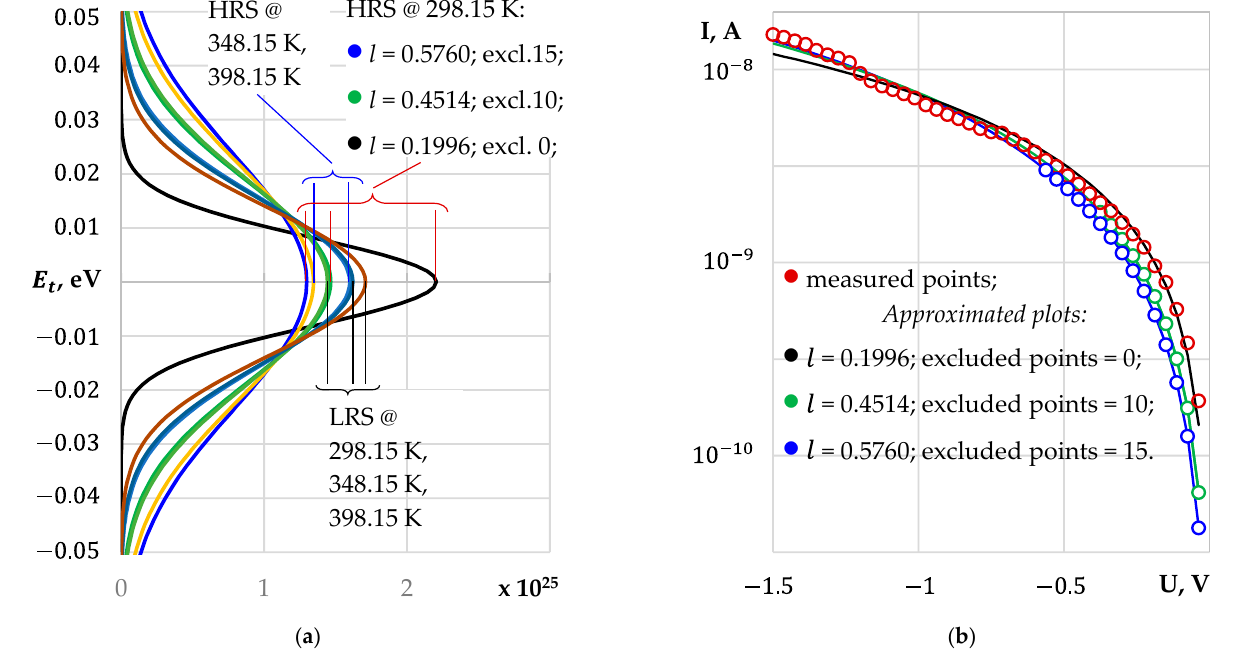
Figure 5. Gaussian distribution of trap states at different temperatures for LRS and HRS. For LRS, an increase in temperature leads to an increase in the maximum of the probability density function ( a ). For HRS, this temperature dependence is expected but not present. The black plot maximum for 298.15 K exceeds the yellow plot maximum for 348.15 K. Examining the approximation plot (black) and the experimental plot (red dots), we see the need to rotate the VAC clockwise ( b ). Excluding the first 10 experimental data points in the low-voltage region gives green plots in ( b , a ) with 𝑙 = 0.4514. Excluding the first 15 experimental data points gives 𝑙 = 0.5760. This results in a reduction in the distribution maximum to the acceptable value (blue plots in ( a , b )). The reason for this effect is explained in the text.